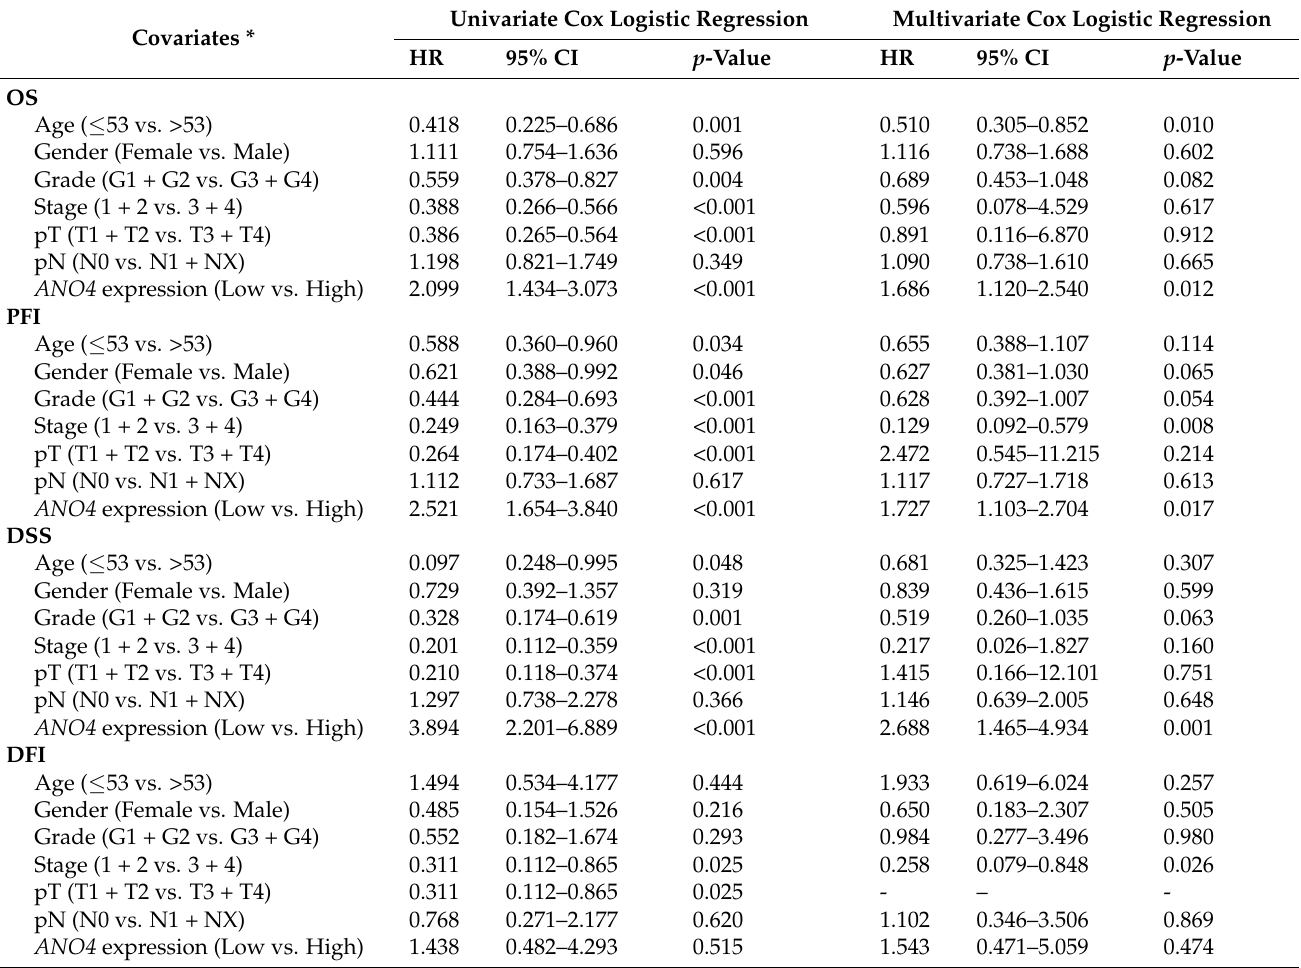
Table 3. Univariate and multivariate Cox logistic regression analysis evaluating the utility of ANO4 expression and relevant clinicopathological covariates in predicting the overall